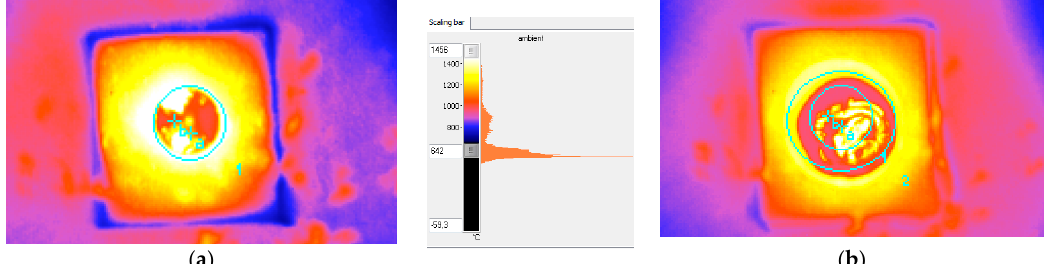
Figure 4. Typical distribution of temperature in molten titanium samples captured by IR camera during solar melting: ( a ) green diameter of 15.1 mm and height of 3.0 mm; ( b ) green diameter of 29.2 mm and height of 5.2 mm. The non ‐ calibrated temperature scale is in the middle . Figure 3. Titanium samples on/in yttria ‐ stabilized zirconia mat: ( a ) Large green compact with diameter of 29.2 mm and height of 5.2 mm prior to solar melting; ( b ) large droplet after solar melting and ( c ) small droplet after solar melting.